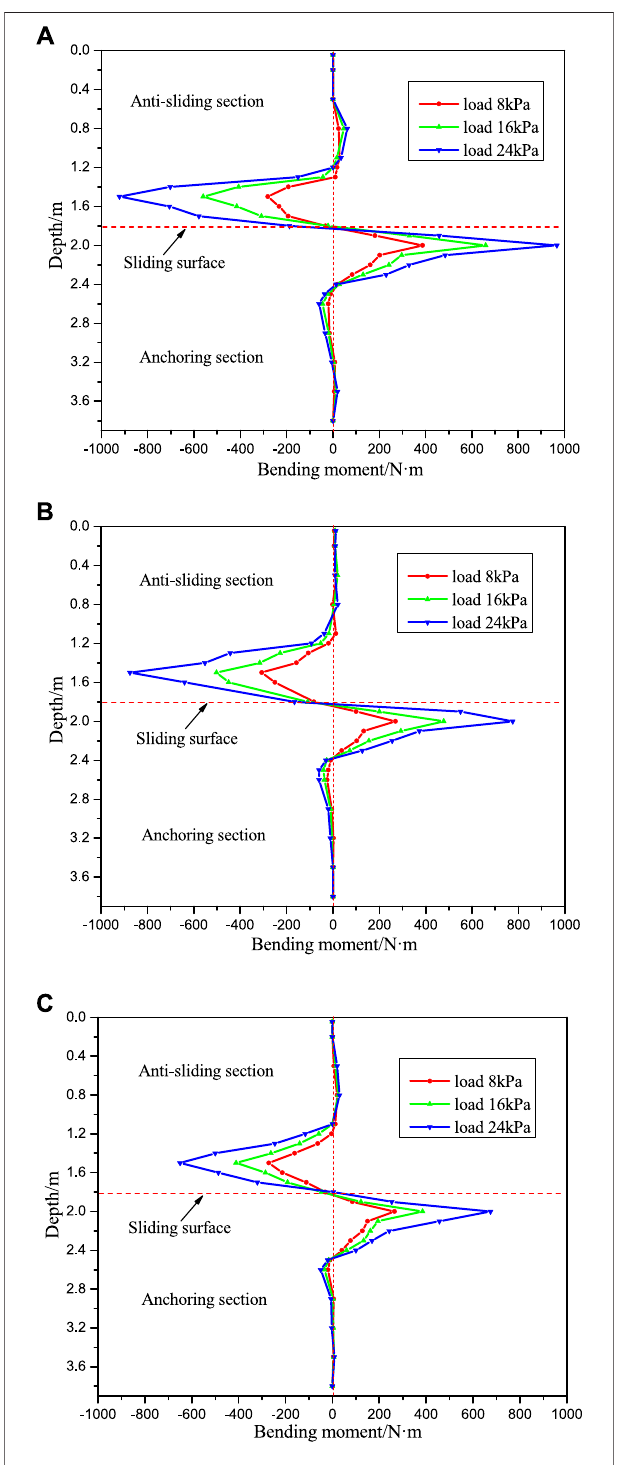
FIGURE14| Bendingmomentofmicropiles: (A) bendingmomentofpile D4, (B) bending moment of pile S5, and (C) bending moment of pile S4.